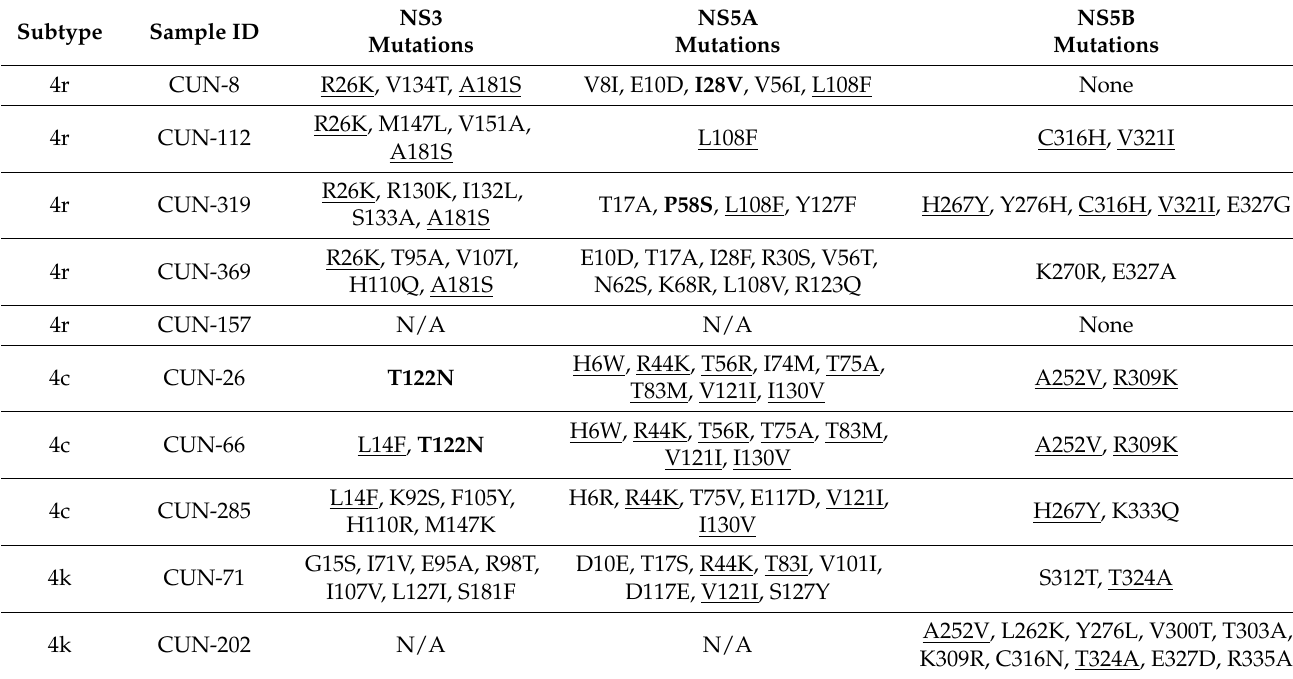
Table 5. Genetic polymorphisms in NS3, NS5A, and NS5B regions among hepatitis C virus (HCV) strains circulating in Kinshasa